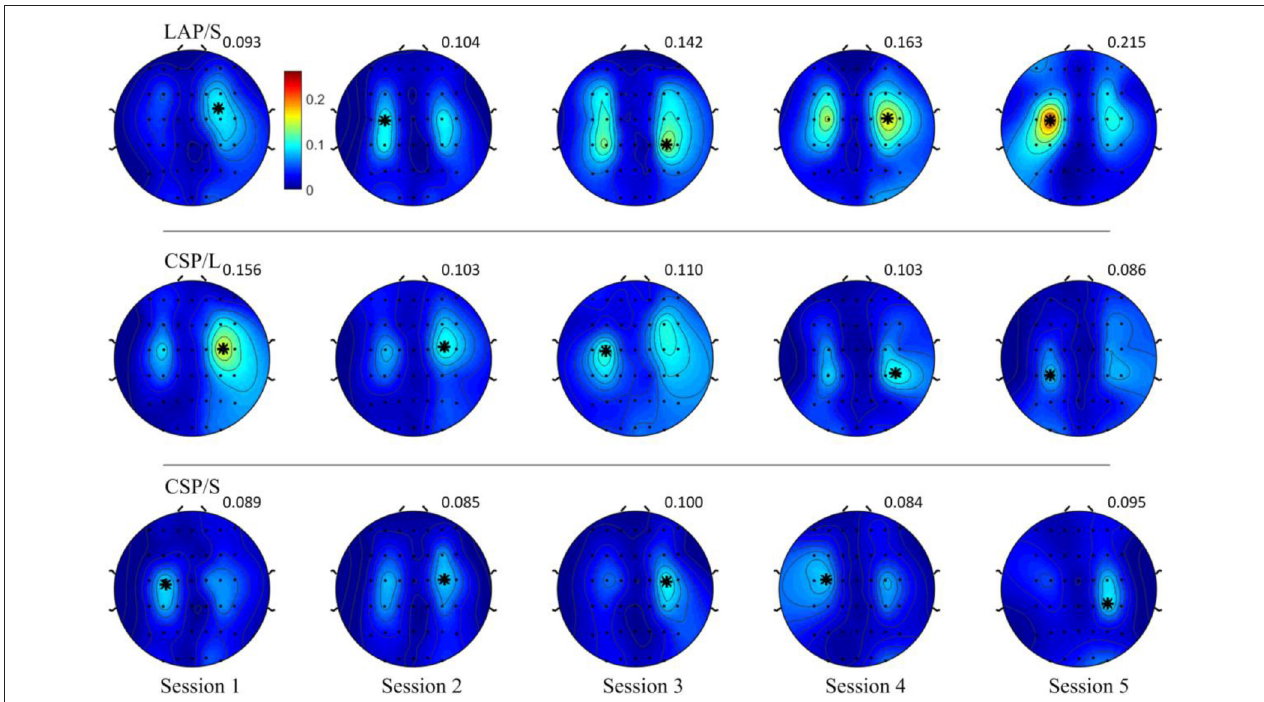
FIGURE 6 | Topography of group averaged R-squared values for the three online decoding methods across five sessions. Each row shows the group results with respect to the different methods, and each column shows the results with respect to each session. The color scale for each method and session is globally normalized. The maximum R-squared value for each condition is marked as a black star and its value is shown rightly above each topography. The group averaged R-squared values for the LAP/S method displayed the largest R-squared value in the focal area surrounding channels C3 and C4 at the fifth session.